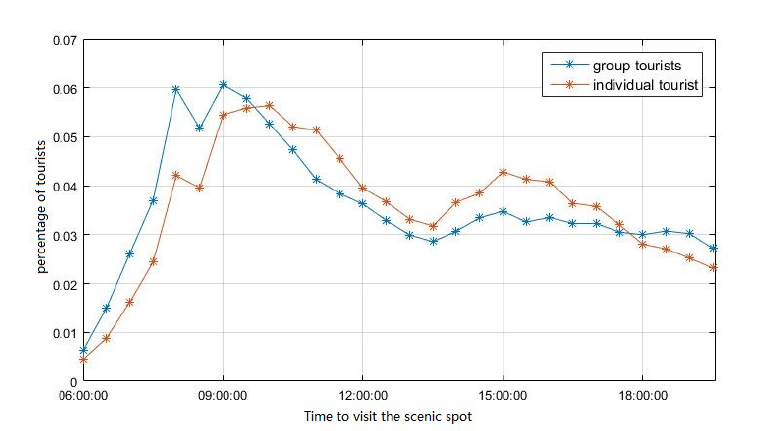
Figure 5. Time to visit the scenic spot for group and individual tourists.